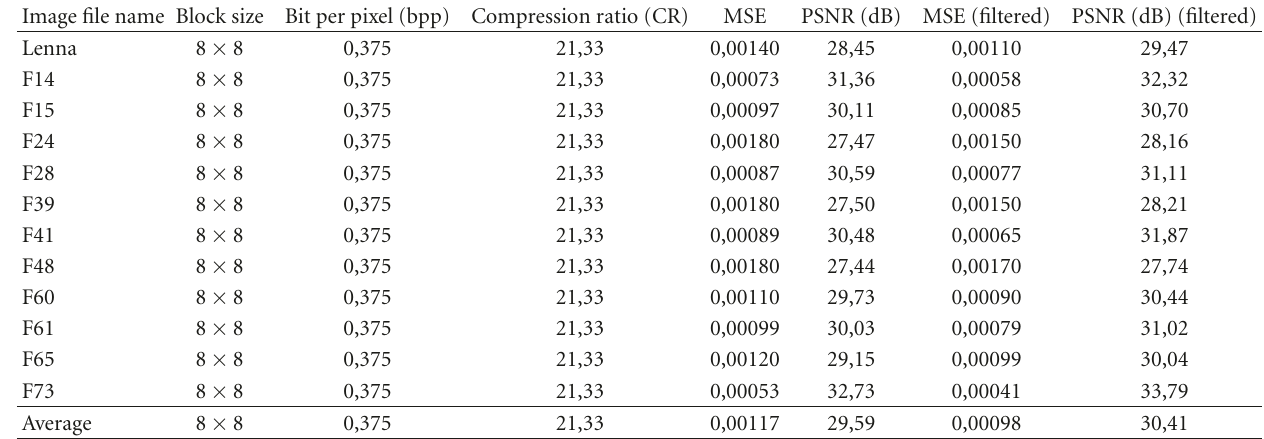
Table 4: Evaluation results of Fold 2.